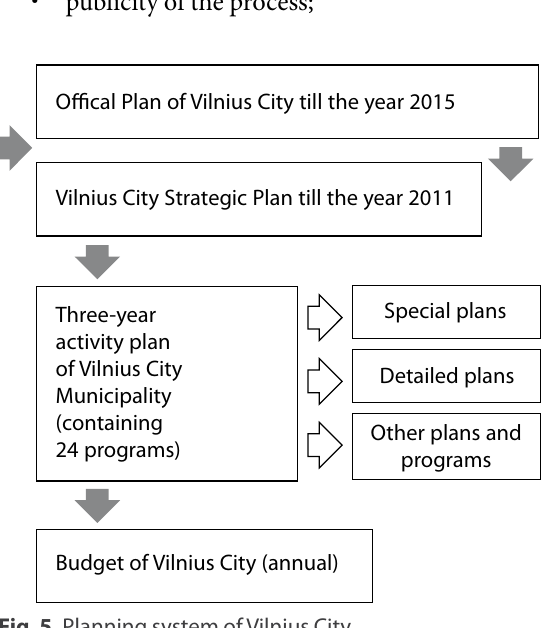
Fig. 5. Planning system of Vilnius